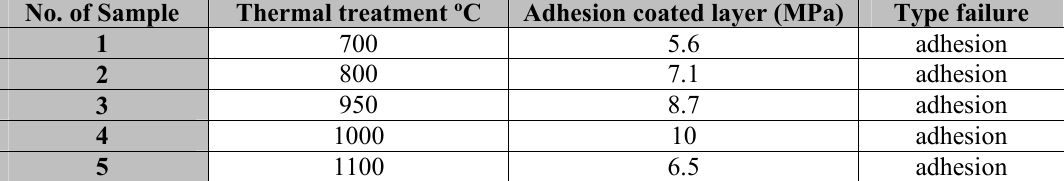
Table 2: Variation of coting adhesion forces with thermal